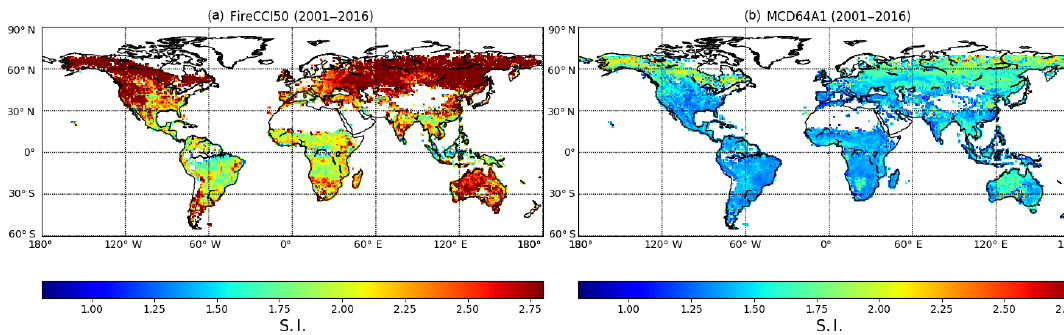
Figure 10. Shape index for FireCCI50 (a) and MCD64A1 c6 (b) .